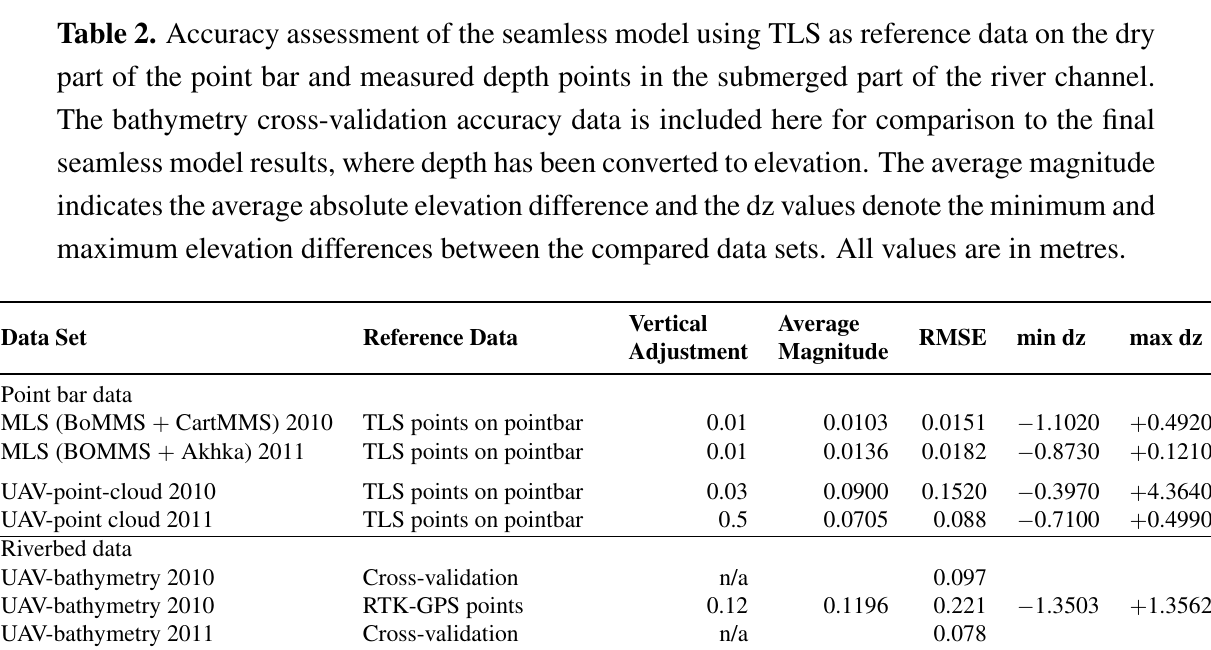
Table 2. Accuracy assessment of the seamless model using TLS as reference data on the dry part of the point bar and measured depth points in the submerged part of the river